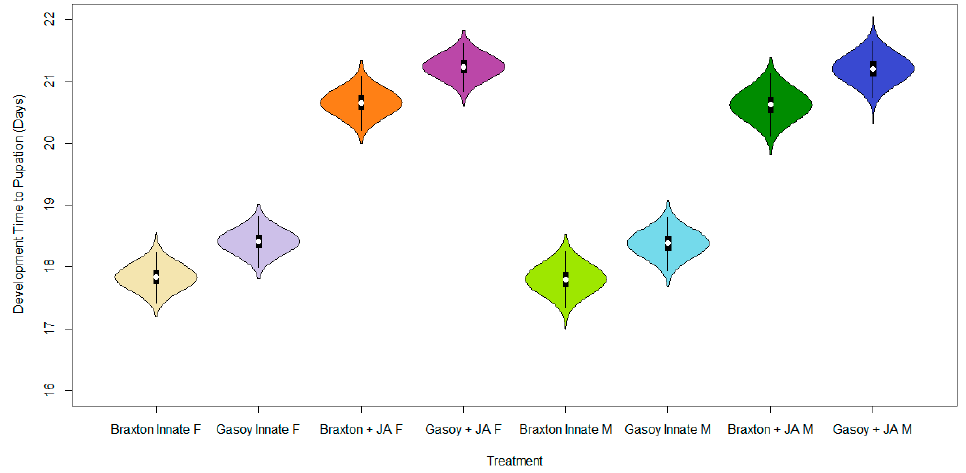
Figure 2. Estimate of S. frugiperda development time to pupation ( y -axis) on different plant cultivars with induction treatments by sex ( x -axis). Larvae reared on Gasoy and JA-induced plants had extended development times. Estimates in the figure are displayed as violin plots, represented as a traditional boxplot overlayed on a kernel density plot of the distribution of the Bayesian posterior estimates. Table 2. Bayesian GLM with main effects parameterization of S. frugiperda development time to pupa- tion across different G. max cultivars, innate/induced jasmonic acid plant defenses, and individuals’ sex. Note that the 95% Credible Intervals (C.I.) for sex overlap